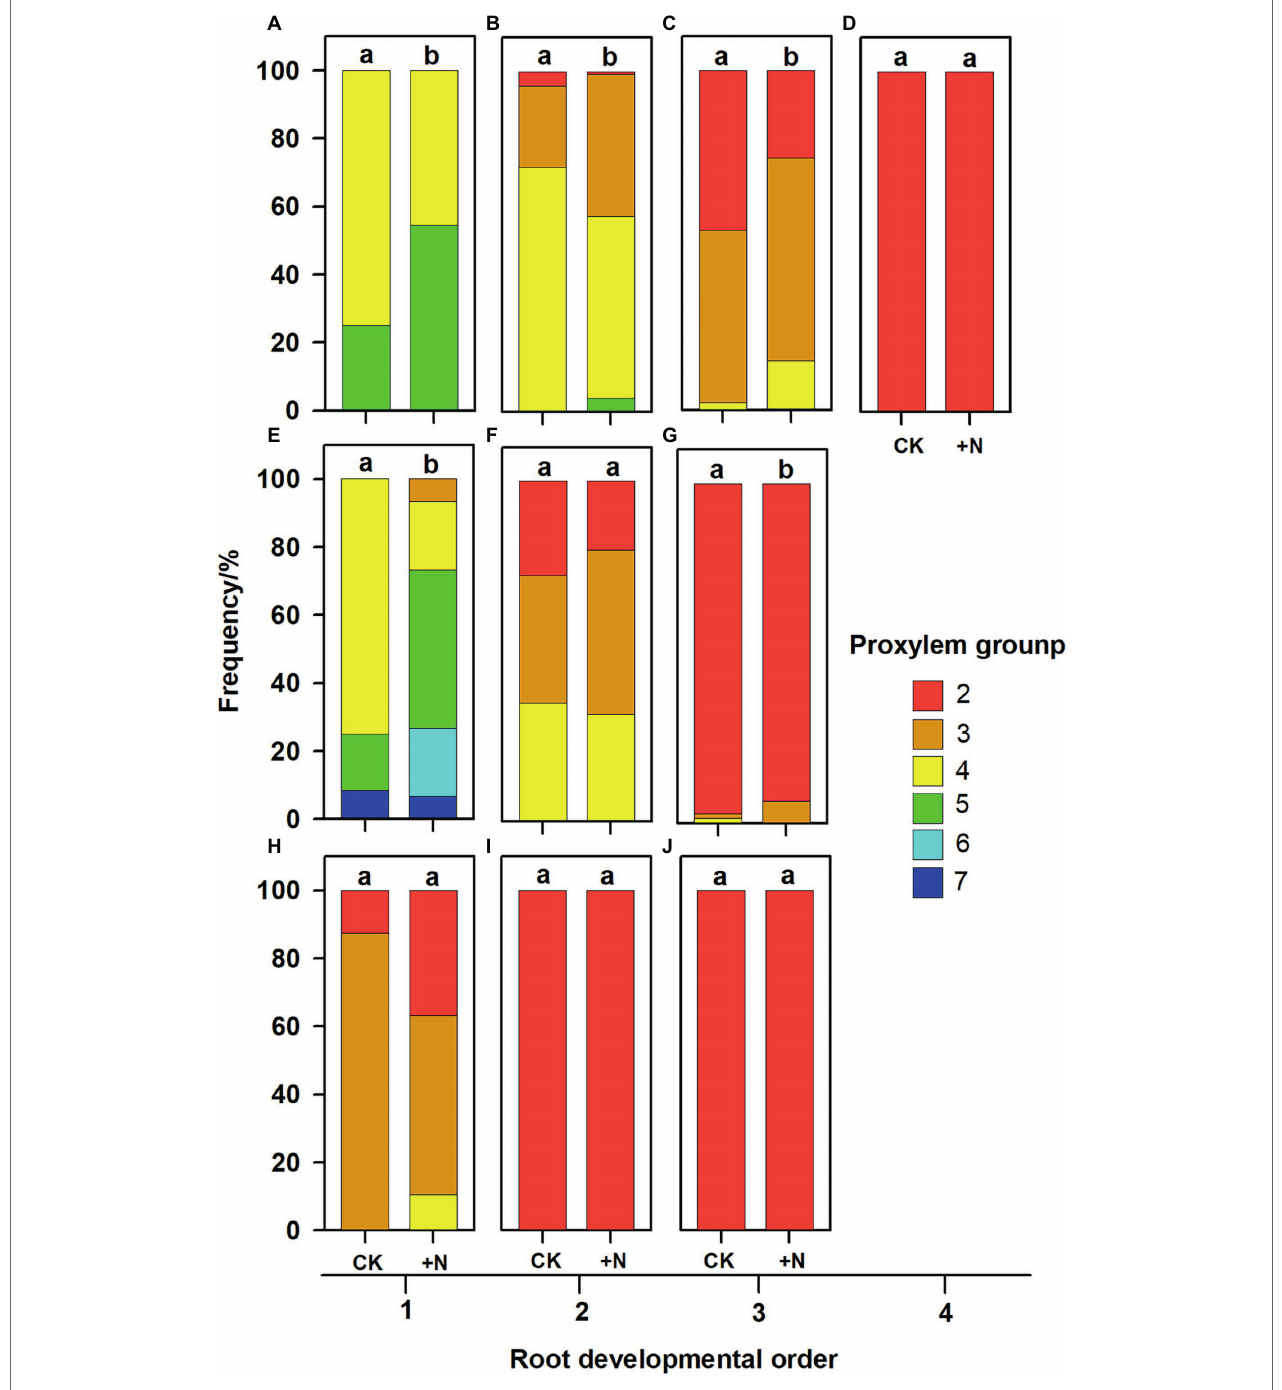
FIGURE 5 | Protoxylem group composition in different root developmental order for Juglans mandshurica (A–D) , Fraxinus mandshurica (E–G) and Phellodendron amurense (H–J) under control (CK) and fertilization (+N), respectively. Different lower-case letters indicate significant differences in composition between control and fertilization within each root developmental order according to chi-square test ( p <